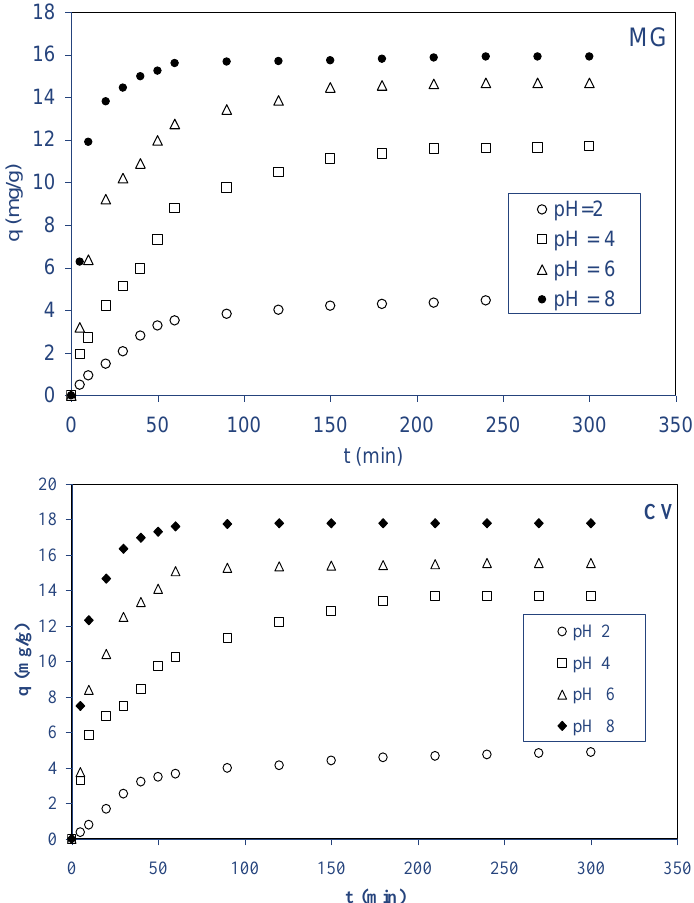
Figure 5. Effect of initial pH on the biosorption of MG and CVon ALP (conditions: C 0 : 40 mg/L; biosorbent dosage: 2.5 g/L; stirring speed: 400 rpm; pH: 2−8, T: 298 K). From the slope and the intercept of the plot of ∆G° versus T, ∆H° and ∆S° values were calculated. The calculated parameters by using the above equations were collected in Ta- ble 4. The negative values of ΔG°, from −1.99 to −2.61 kJ mol −1 for MG and from −15.24 to